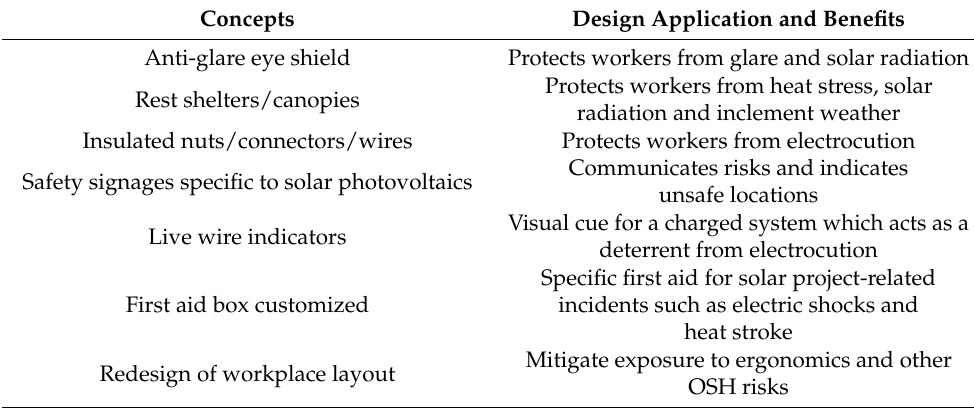
Table 6. Summary of design opportunities (not